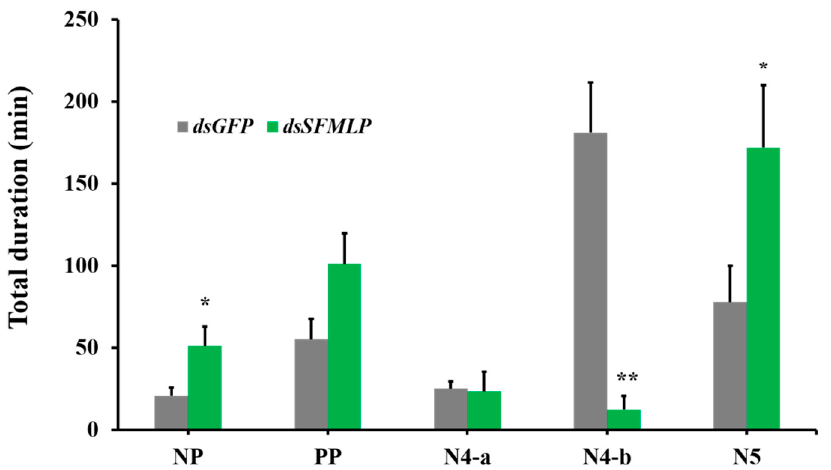
Figure 4. Effects of SFMLP knockdown on feeding behaviour of WBPH ds GFP indicates WBPH injected with GFP - dsRNA ; dsSFMLP indicates WBPH injected with SFMLP - dsRNA . * and ** indicate statistically significant differences ( t- test: p < 0.05 and p < 0.01). Bars, ±SEM.